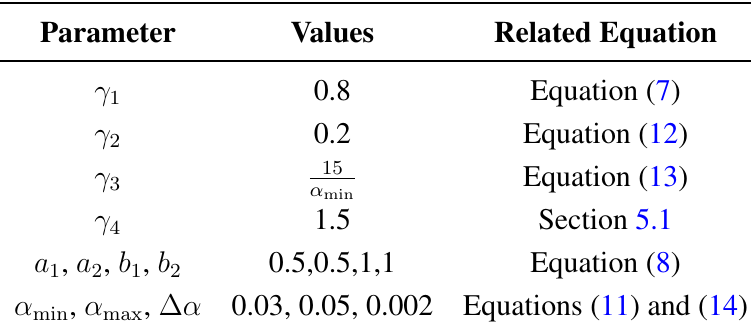
Table 2. Parameters used in the experiment.